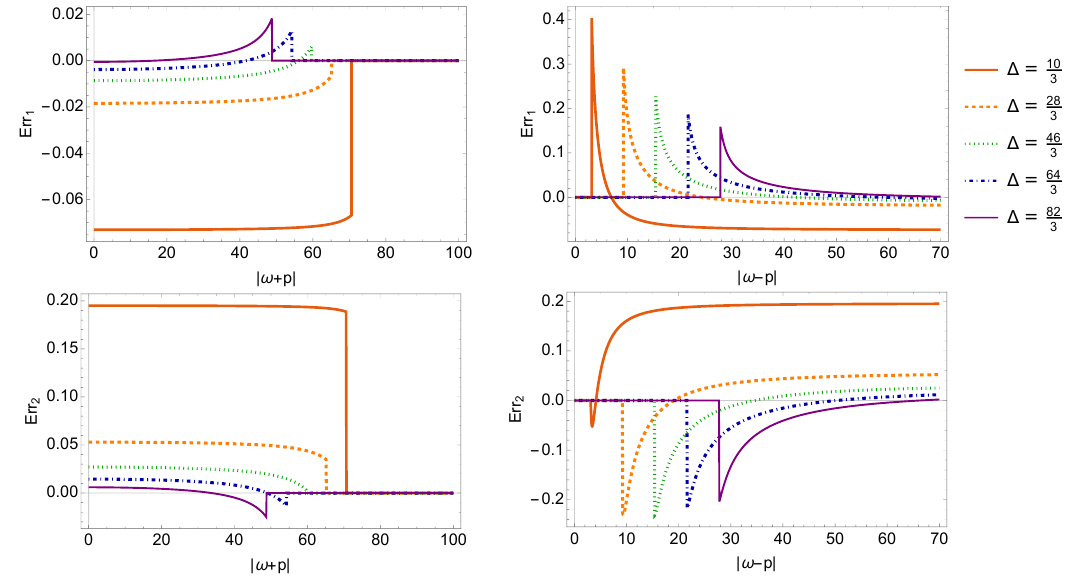
Figure 15: The error functions of the WKB formula (2.17), Err (D.4), for a Global 1 / 2 AdS geometry as a function of | ω − p | , | ω + p | and ∆ . The graphs on the left give 3 Err and Err as functions of | ω − p | for different values of ∆ and for | ω + p | = 1 / 2. 1 2 The graphs on the right give Err and Err as functions of | ω + p | for the same values 1 2 of ∆ and for | ω − p | = 80. Each curve has a sharp ending point which corresponds to the point where (3.53) is not satisfied